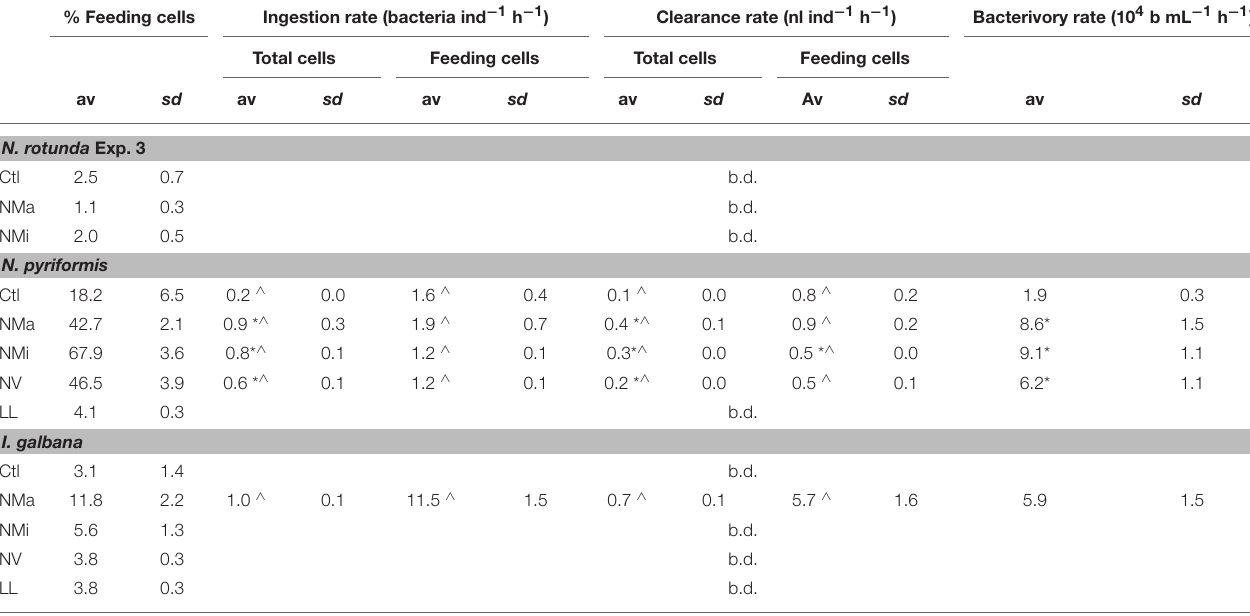
TABLE 4 | Bacterivory rates and ingestion and clearance rates determined for all phytoplankton cells and exclusively for feeding cells. % Feeding